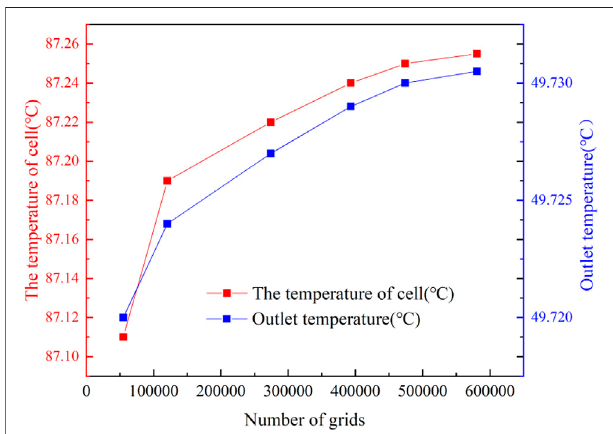
FIGURE 4 | Temperature of the cell and outlet temperature under different grid